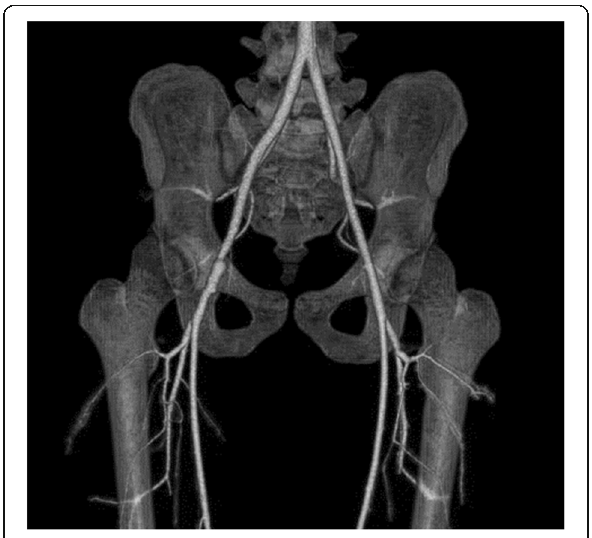
Fig. 3 Postoperative CT angiography shows a patent right EIA and CFA and a successful repair. CT, computed tomography; EIA, external iliac artery; CFA, common femoral artery